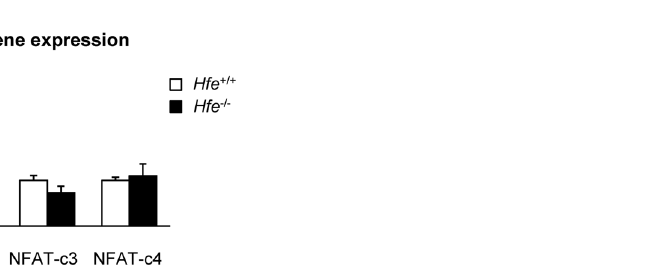
Figure 3. Cardiac fibrosis in Hfe + / + and Hfe − / − mice. Heart tissues from 12-month old Hfe − / − mice and their age-matched wild-type mice were fixed in 4% formalin, embedded in paraffin and sectioned into 5 µ m thin slices, which were mounted on microscope slides for H&E and Masson’s trichrome staining. Arrows indicate the areas of fibrosis.